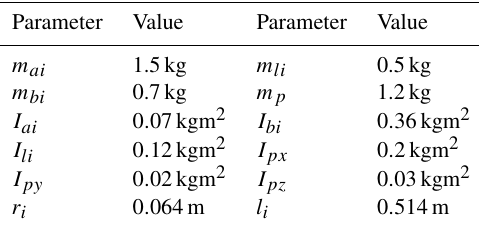
3 Robust task-space trajectory tracking control